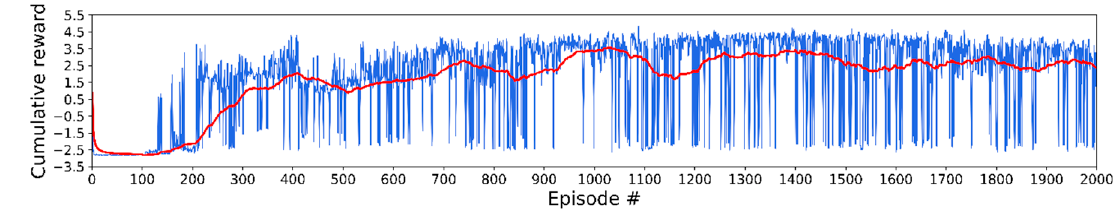
Figure 4. Scores and average scores in total training episodes.